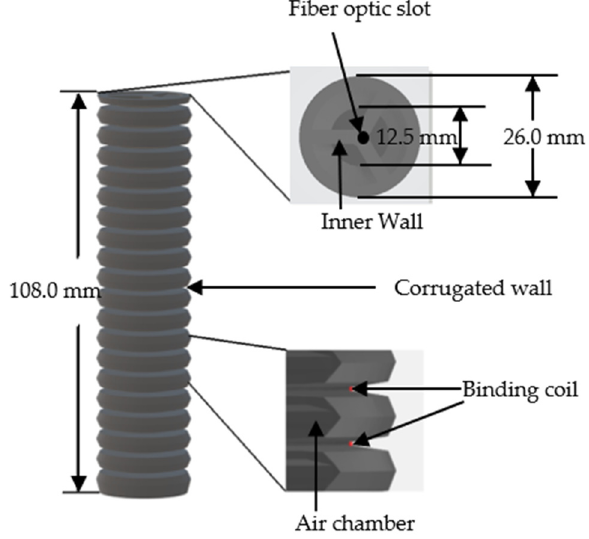
Figure 1. The structure of the soft actuators. The manipulator consists of two end-to-end actuators and a joining part which is a rigid joint between the two tentacles with three air inlets for the second tentacle.